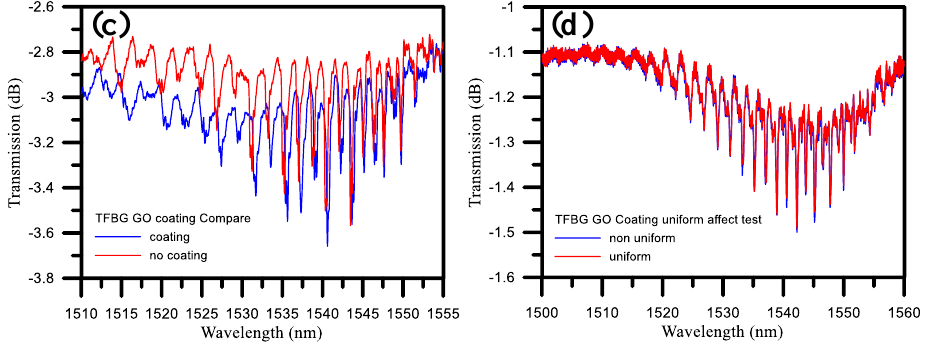
Figure 5. ( a ) Scanning Electron Microscope (SEM) image of TFBG coated with graphene oxide film, ( b ) SEM image of graphene oxide film, ( c ) TFBG GO coating comparison, ( d ) TFBG GO uniform coating comparison.